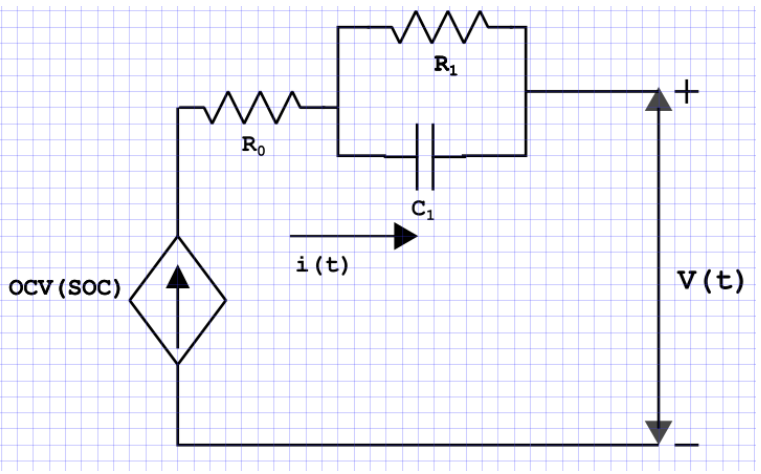
Figure 3. 1-RC pair model. Where V is the terminal voltage (V), V OCV is the Open Circuit Voltage (V).